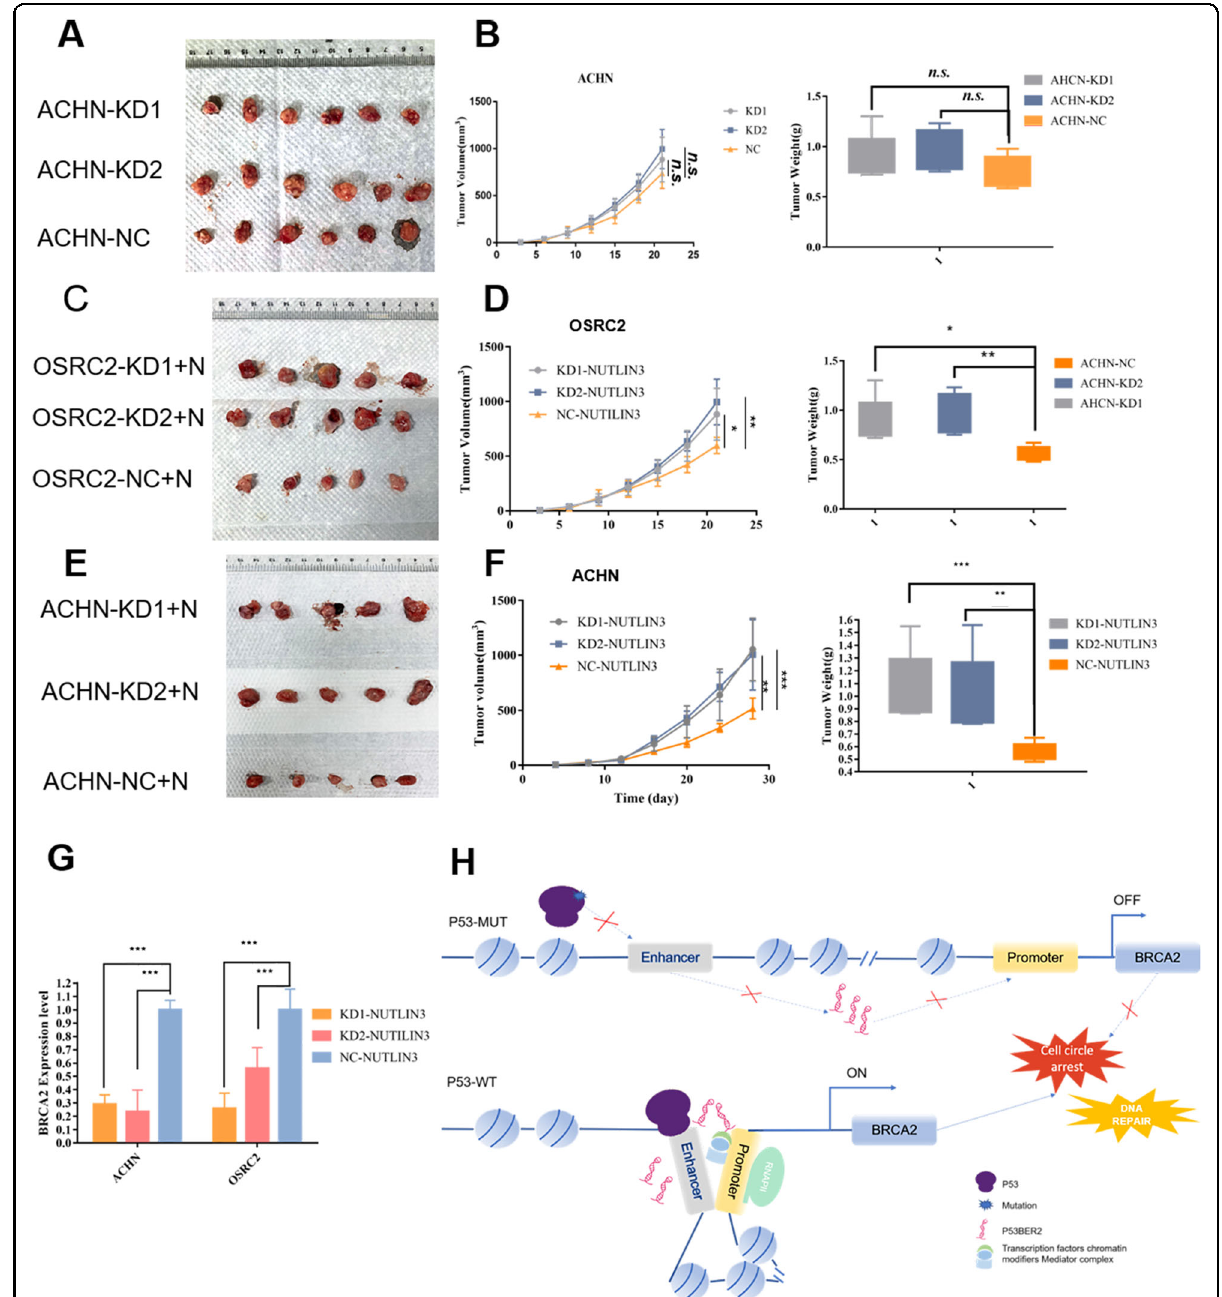
Fig. 6 Downregulation of P53BER2 shows resistance to nutlin-3 treatment in cell-derived xenografts (CDXs). A Image of 18 xenografts formed by ACHN-KD1, KD2, and Control. B Growth curves of mice subcutaneous xenografts derived from ACHN-KD1, KD2, and Control cells (left panel). Tumor weights were statistically analyzed (right panel). C Image of 15 xenografts formed by OSRC-2-KD1, KD2, and Control with nutlin-3 treatment. D Growth curves of mice subcutaneous xenografts derived from OSRC-2-KD1, KD2, and Control cells with nutlin-3 treatment (left panel). Tumor weights were statistically analyzed (right panel). E Image of 15 xenografts formed by ACHN-KD1, KD2, and Control with nutlin-3 treatment. F Growth curves of mice subcutaneous xenografts derived from ACHN-KD1, KD2, and Control cells with nutlin-3 treatment (left panel). Tumor weights were statistical analyzed (right panel). G BRCA2 expression in mice subcutaneous xenograft. Results are shown as mean ± SD. *** P < 0.001 compared with control. ** P < 0.01 compared with control. * P < 0.05 compared with control. H Schematic model of P53BER2-dependent regulation of P53 activity in p53-MUT or TP53-WT